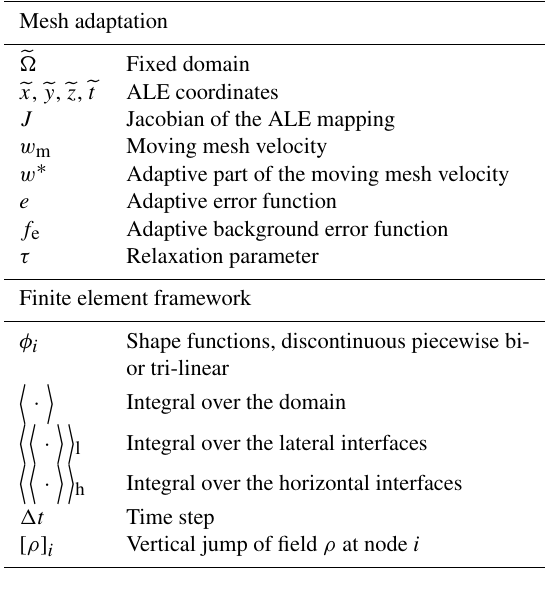
impermeability at the bottom and the coast, bottom friction and surface wind stress. Further details about the governing equations are given in Kärnä et al.